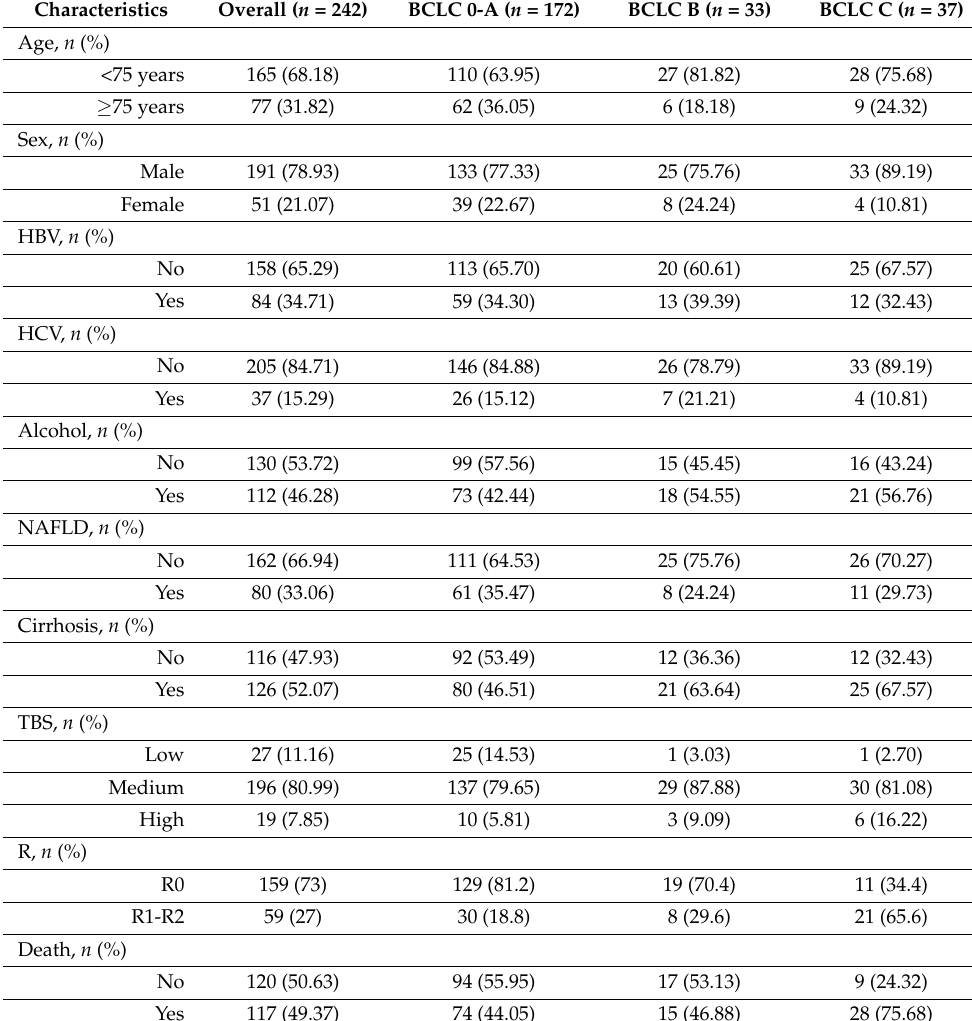
Table 1. Demographic, clinical, and pathological characteristics of patients stratified according to the BCLC